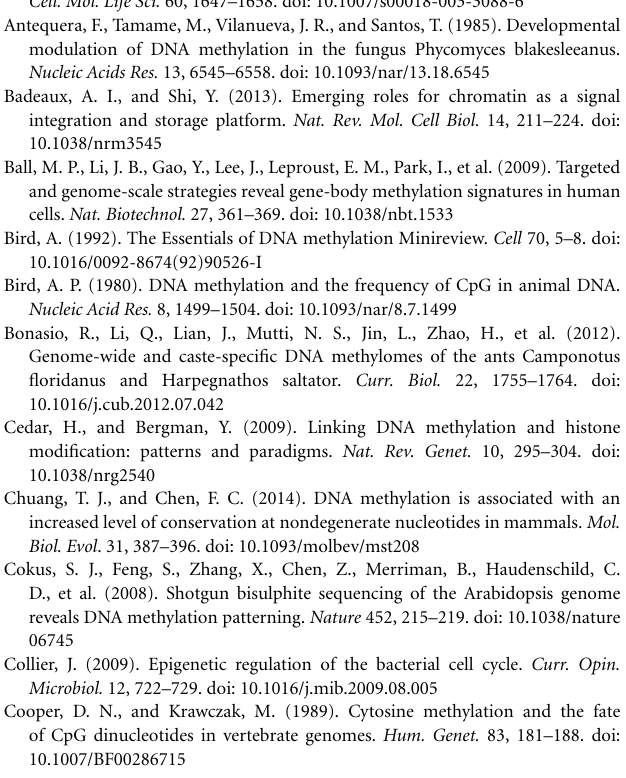
significant). Development and gametogenesis stages are indicated. F, female; M, male; St0, sexual resting; St3, mature gametes; α , alpha fertile phenotype; β , beta sterile phenotype (Riviere et al., in preparation). ∗∗ p < 0 . 01; ∗∗∗ p < 0 . 001; One-way ANOVA for number of methylated exons/million mapped